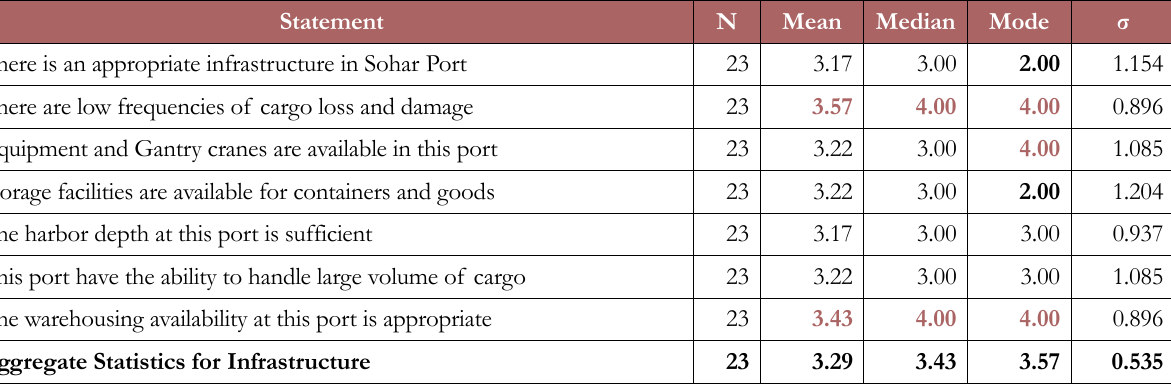
Table 4. Shipping Lines and Agents Perspectives on Sohar Port Infrastructure